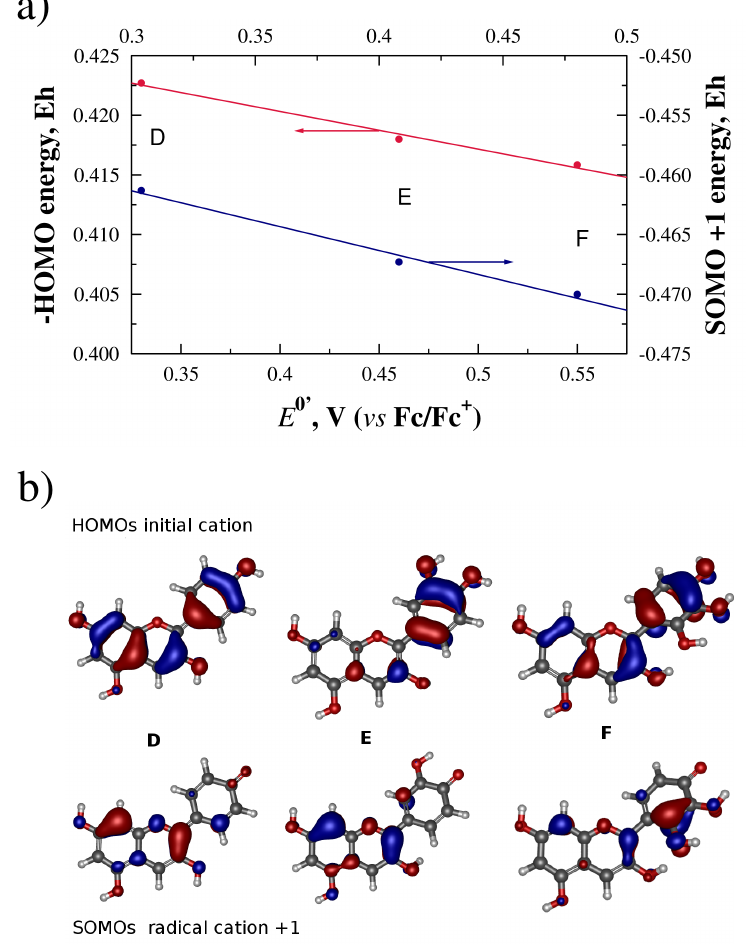
Figure 5. ( a ) linear correlations between E (cid:48) potentials, in volts, HOMO and SOMO orbital energies of 0 radical anions, in Hartrees. The sign of the HOMO energies were reversed to plot trends with similar slopes; and ( b ) HOMOs for cationic anthocyanidins and SOMOs for radical cation +1 for pelargonidin (D), cyanidin (E), and delphinidin (F), calculated at the HF/SVP level of